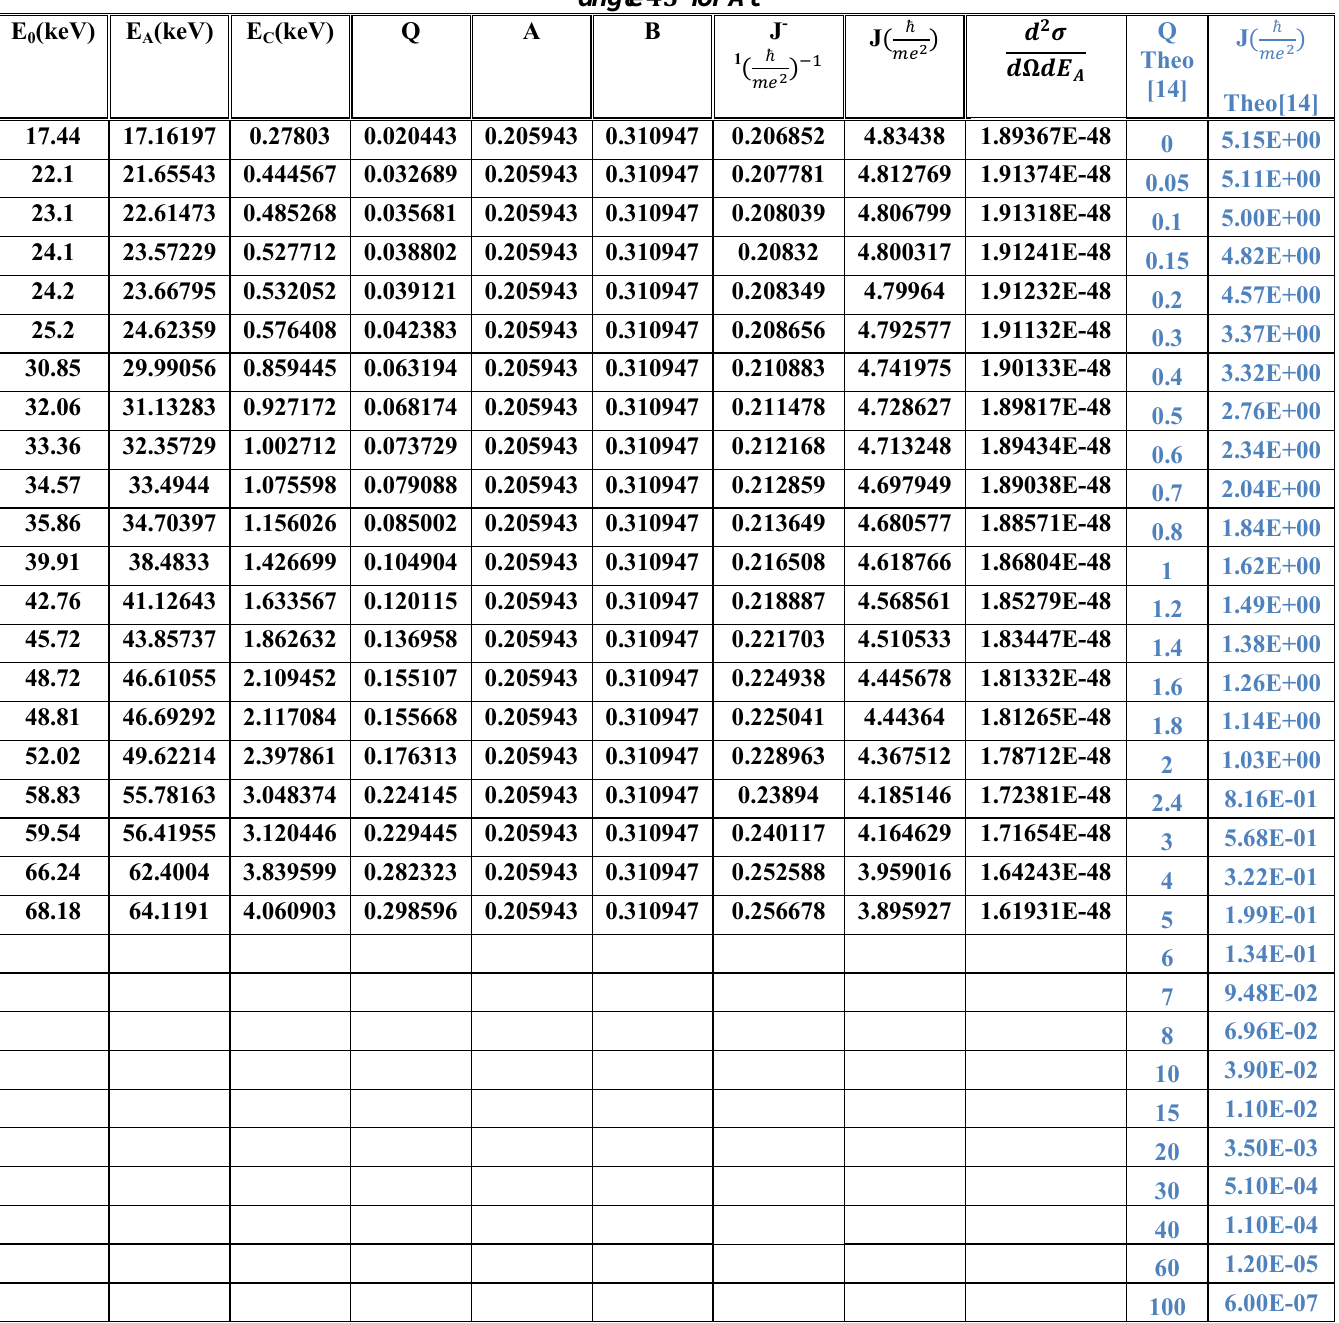
Table 2: The double-differential scattering cross section of Doppler broadening at angle (cid:2781)(cid:2782) ° for